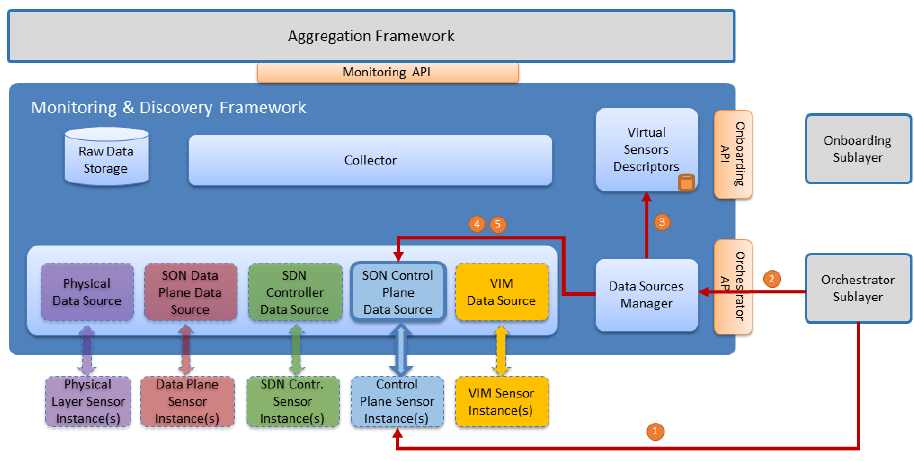
Figure 12. Sensor Instance Removal Workflow.